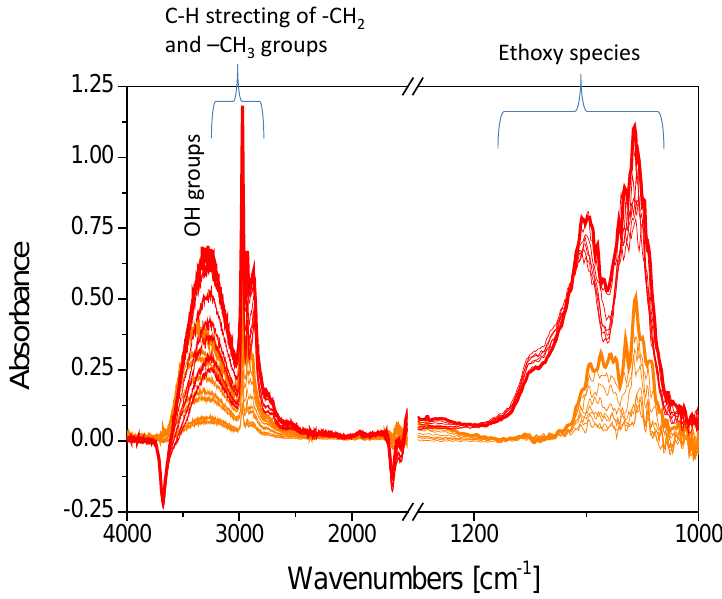
Figure 14. Comparison among the spectra collected upon 5 mbar ethanol adsorption and at reducing CO pressures at r.t. on TiO 2 (red curves) and I1.0Cu/TiO 2 (orange curves).